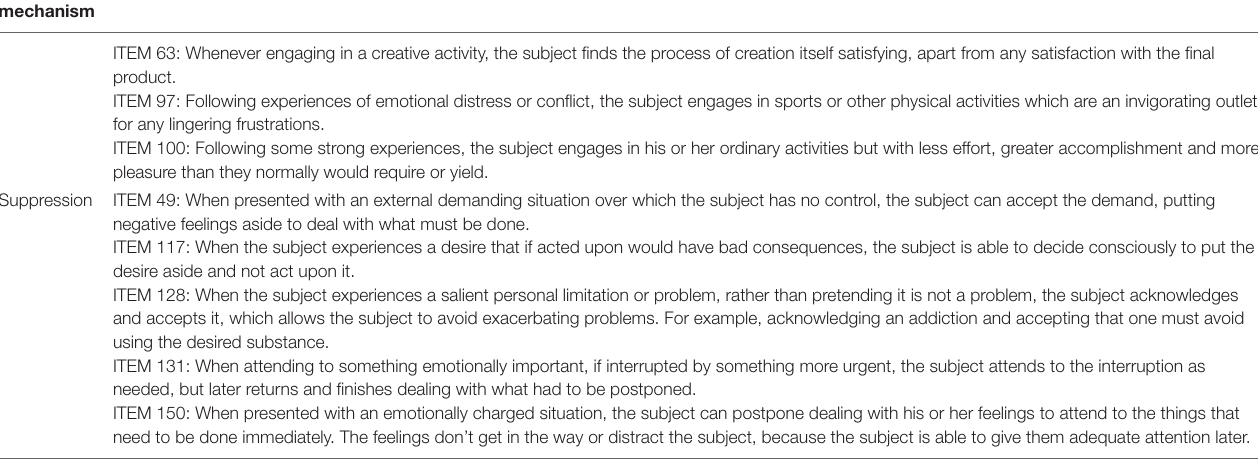
TABLE 3 | Obsessional defense level: Definition, function and DMRS-Q items of defenses isolation of affects, intellectualization and undoing. Defense